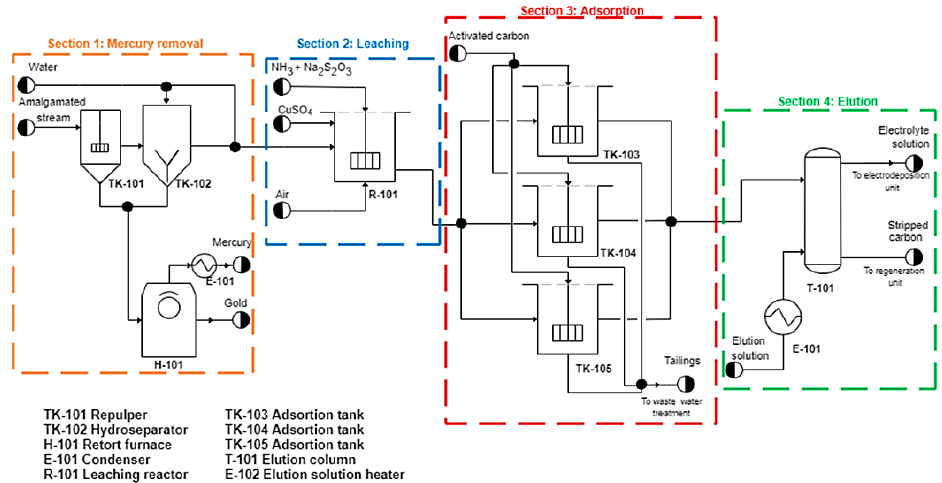
Figure 2. Process flow diagram for hydrometallurgical gold recovery using sodium thiosulfate as a leaching agent.